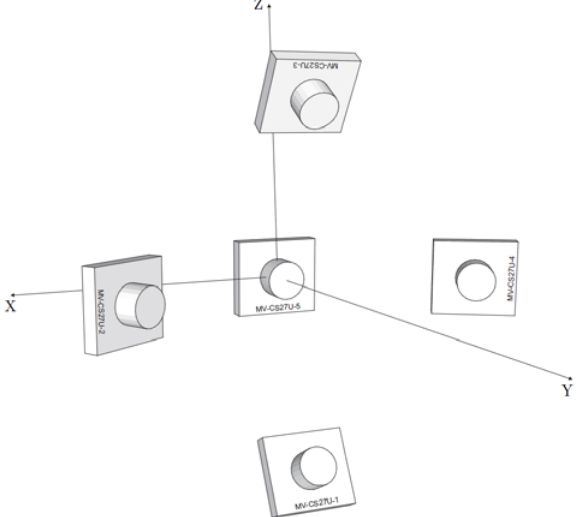
Figure 11: „Australis“ coordinate